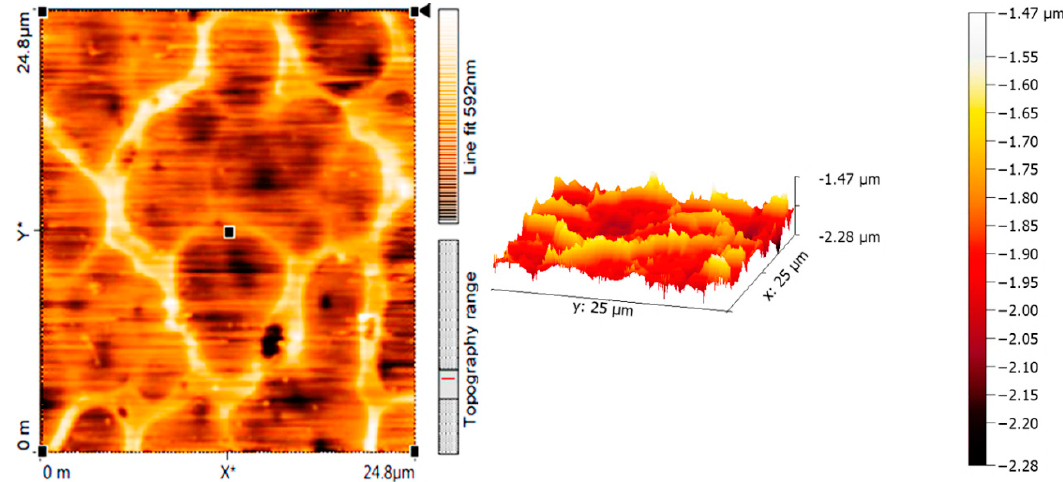
Figure 12. 2D and 3D AFM images of PVC film containing 1 after irradiation (300 h).